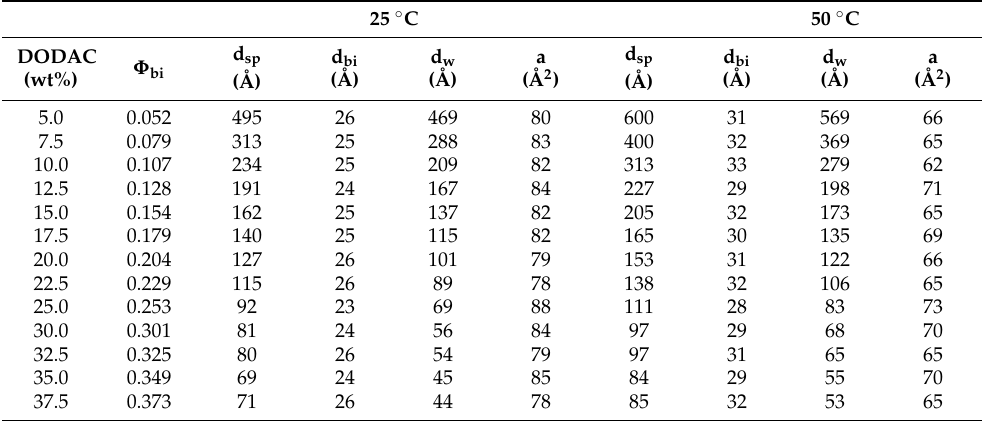
Table 2. Calculated values of the bilayer volume fraction ( Φ bi ), the interlamellar spacing (d sp ), bilayer in water at temperatures below (25 ◦ C) and above (50 ◦ C) the main phase transition